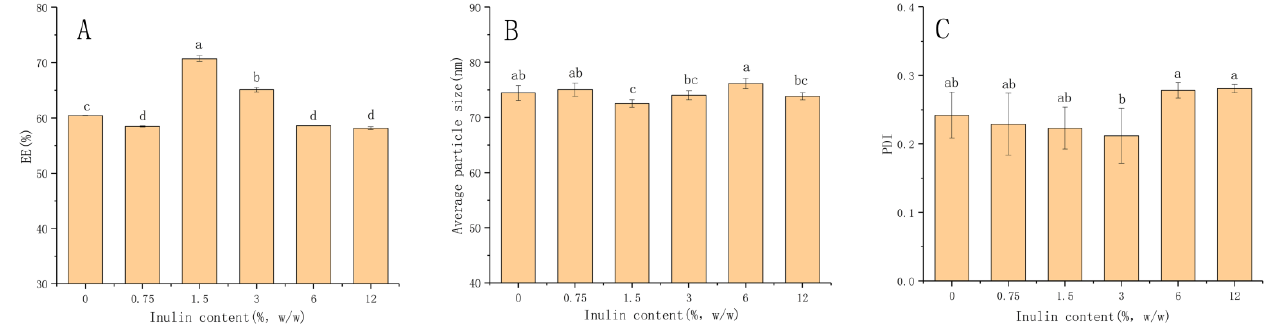
Figure 1. Modified cinnamaldehyde liposomes at different inulin concentrations. ( A ) EE; ( B ) Average particle size; ( C ) PDI. Results are represented as the mean ± sd (n = 3). Different letters represent a significant difference ( p < 0.05). EE: encapsulation efficiency; PDI: polydispersion index.